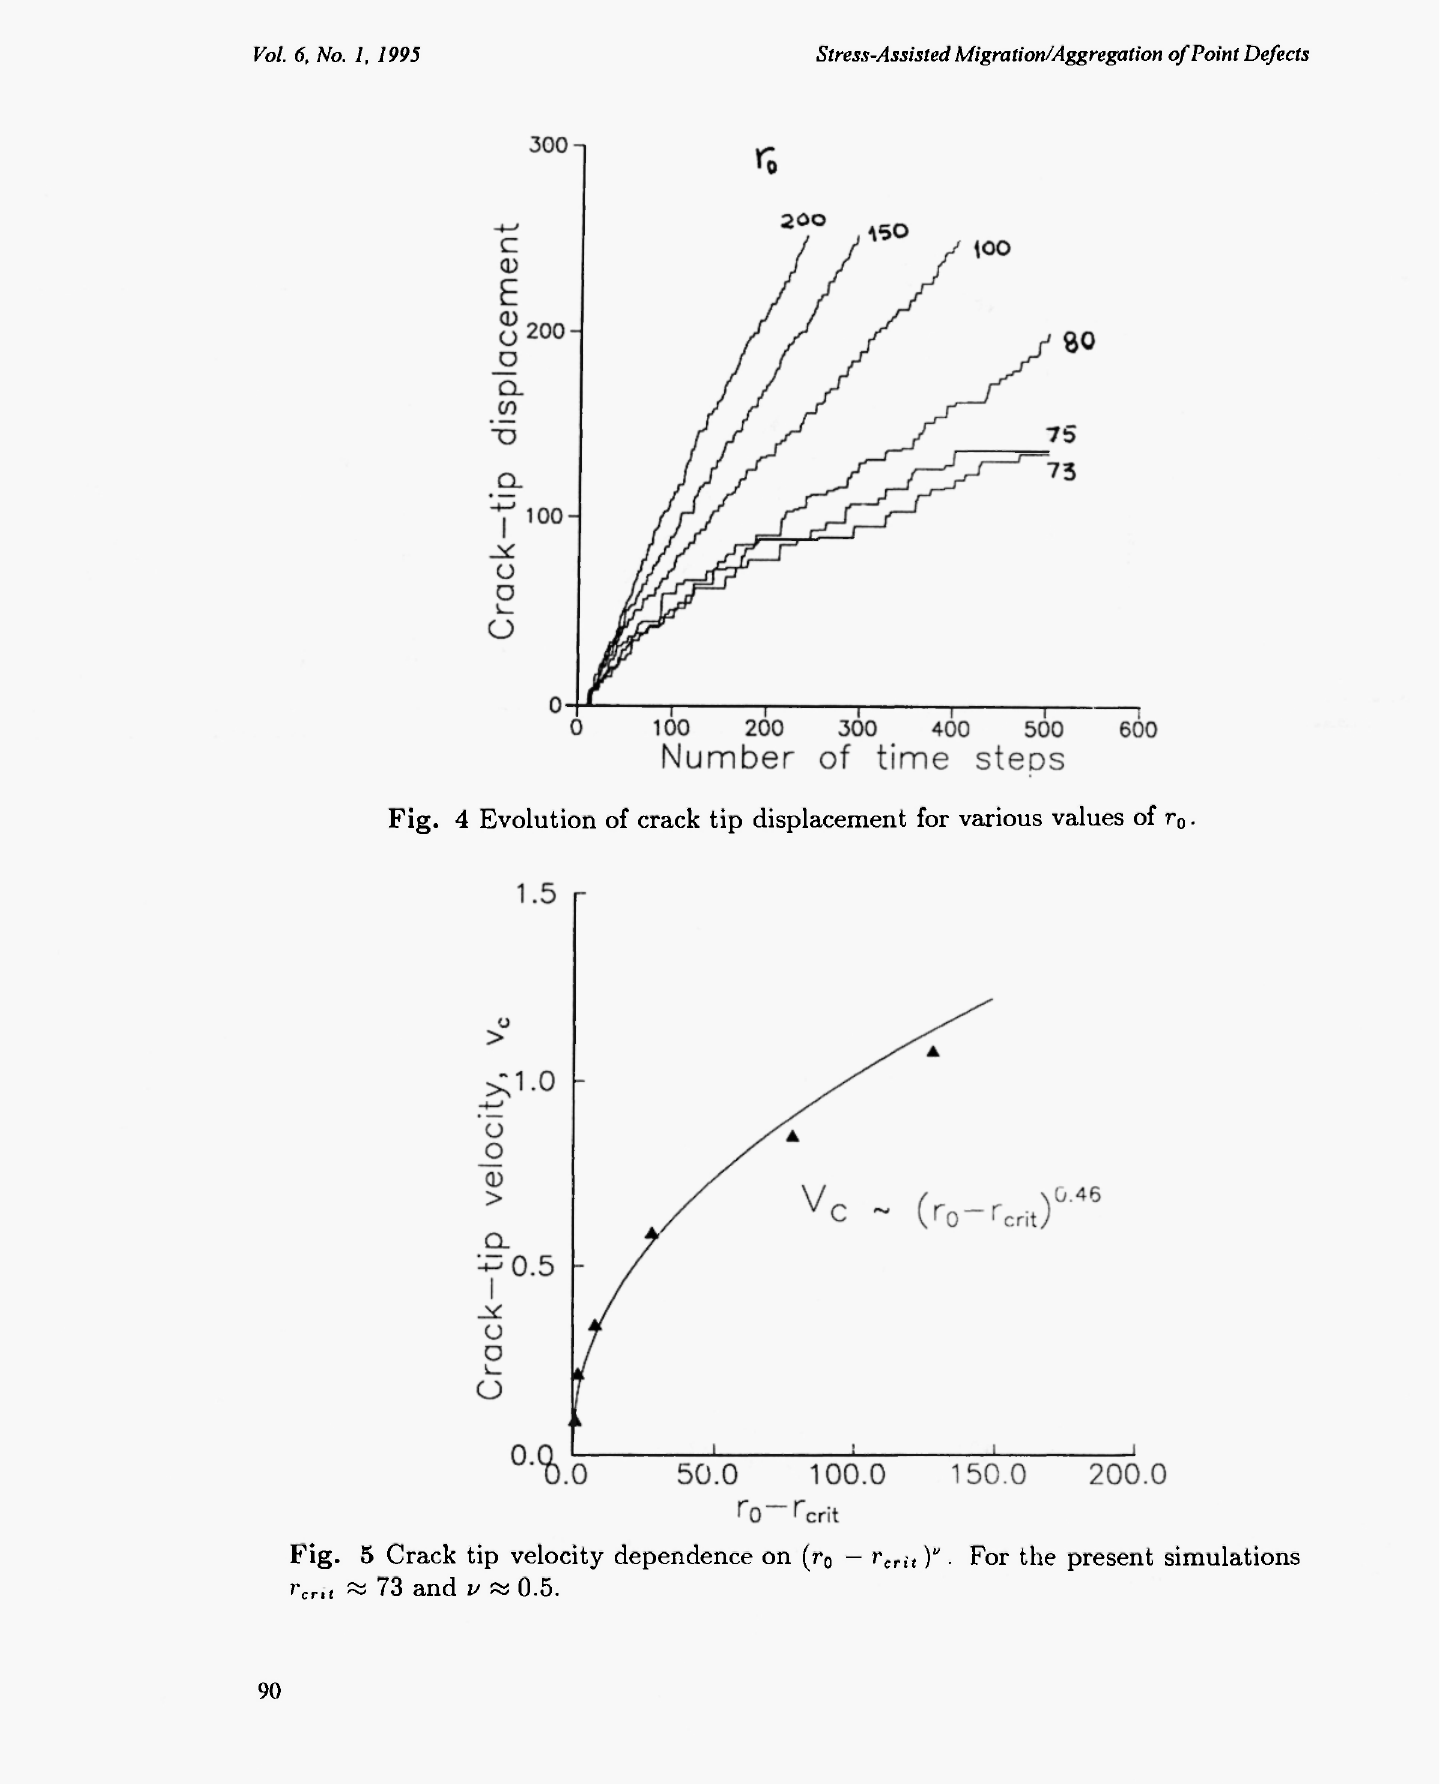
Fig. 5 Crack tip velocity dependence on (r 0 — r